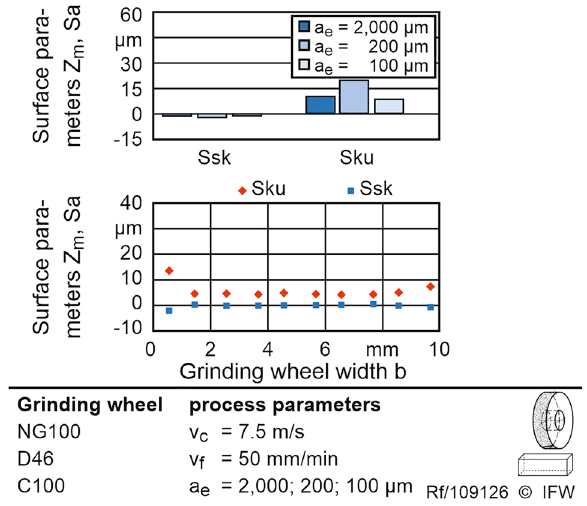
Fig. 6 Influence of sharpening on Ssk and Sku of reference grind- ing wheel NG100